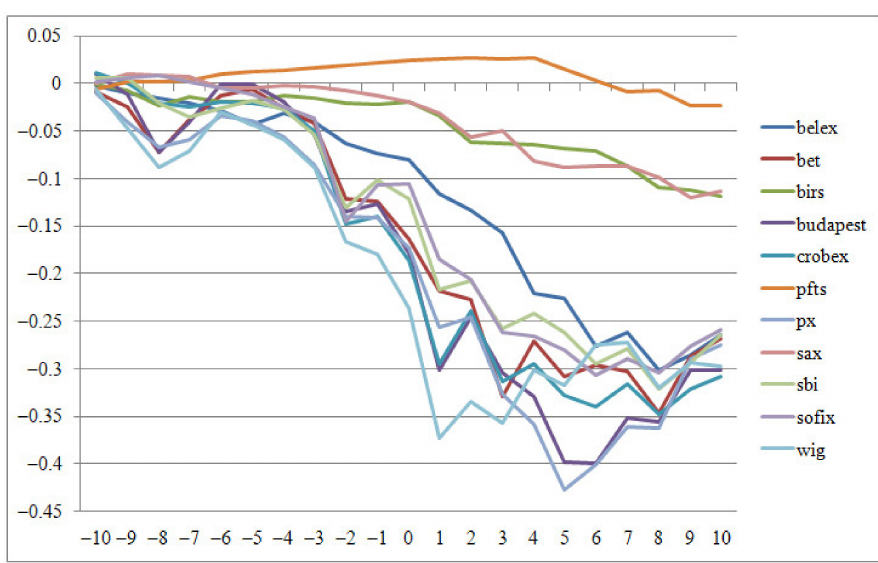
Figure 3. CARs for all countries, event